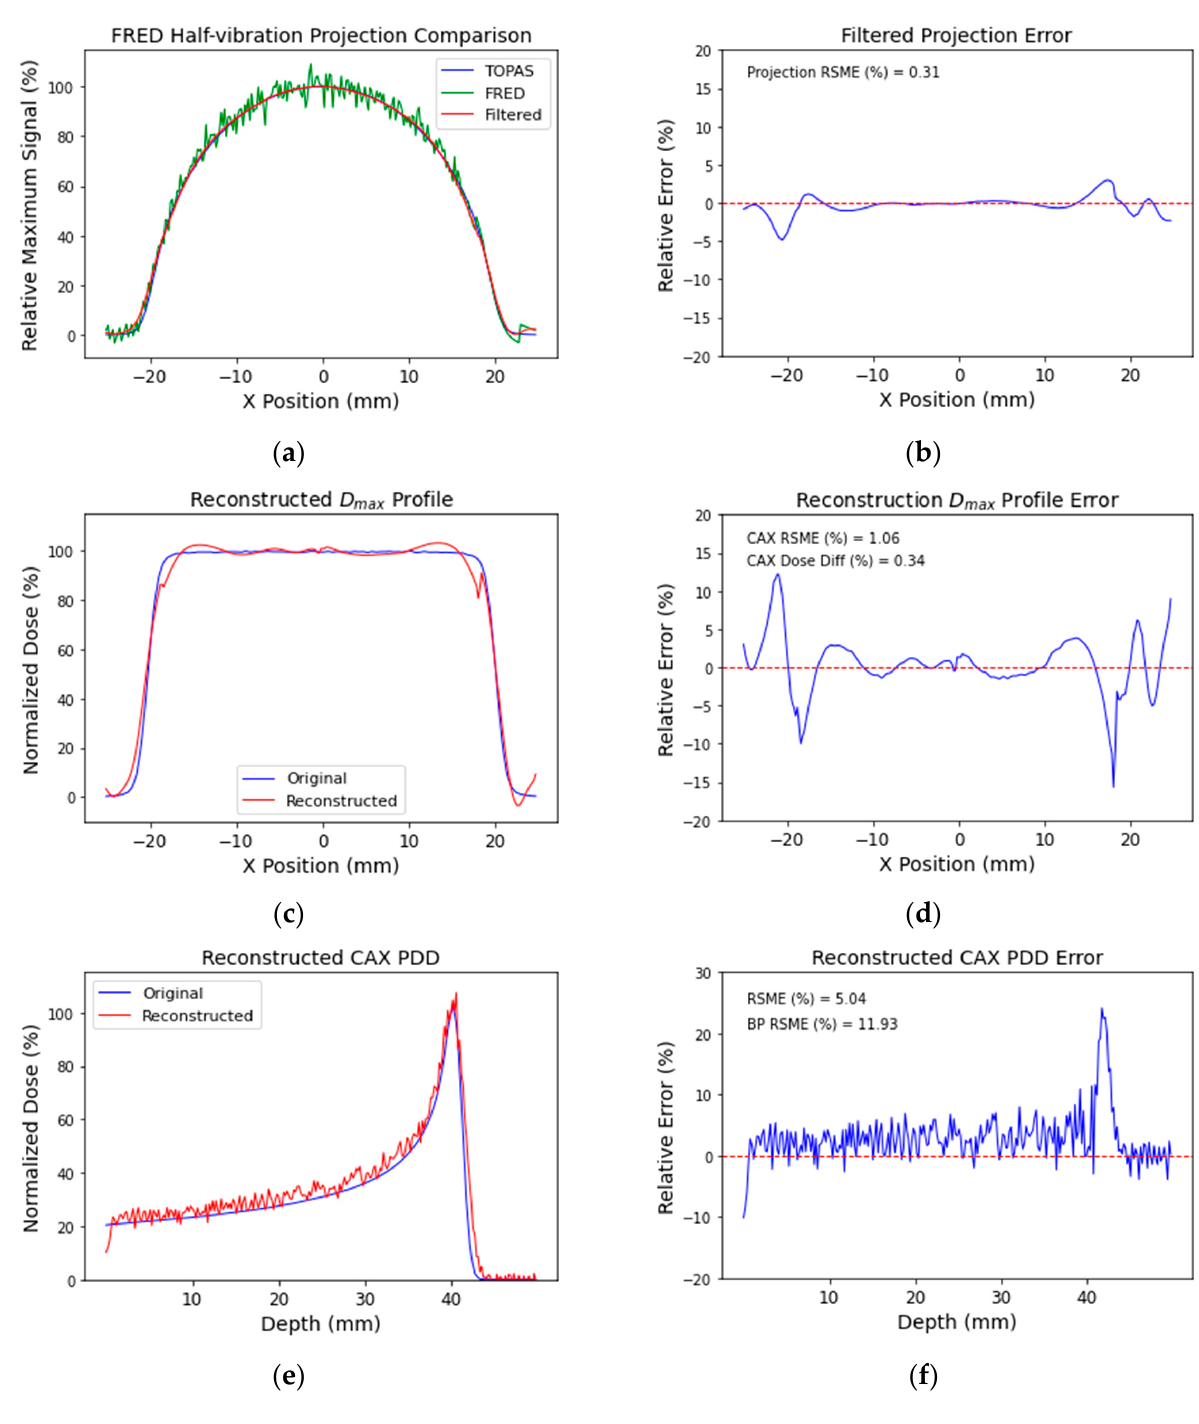
Figure 9. Comparison of half-vibration projection data and the reconstructed distribution D max profile and CAX PDD. The profile through the projection data at the depth of dose maximum for the MC 3D distribution, the half-vibration FRED projection data, and the filtered FRED projection data ( a ) are compared, and the percentage error between the MC projection and filtered projection is shown in ( b ). The reconstructed profile ( c ) and PDD ( e ) are compared with the MC distribution, with the percentage error between the MC data and reconstructed data shown for the profile ( d ) and PDD ( f ), respectively.